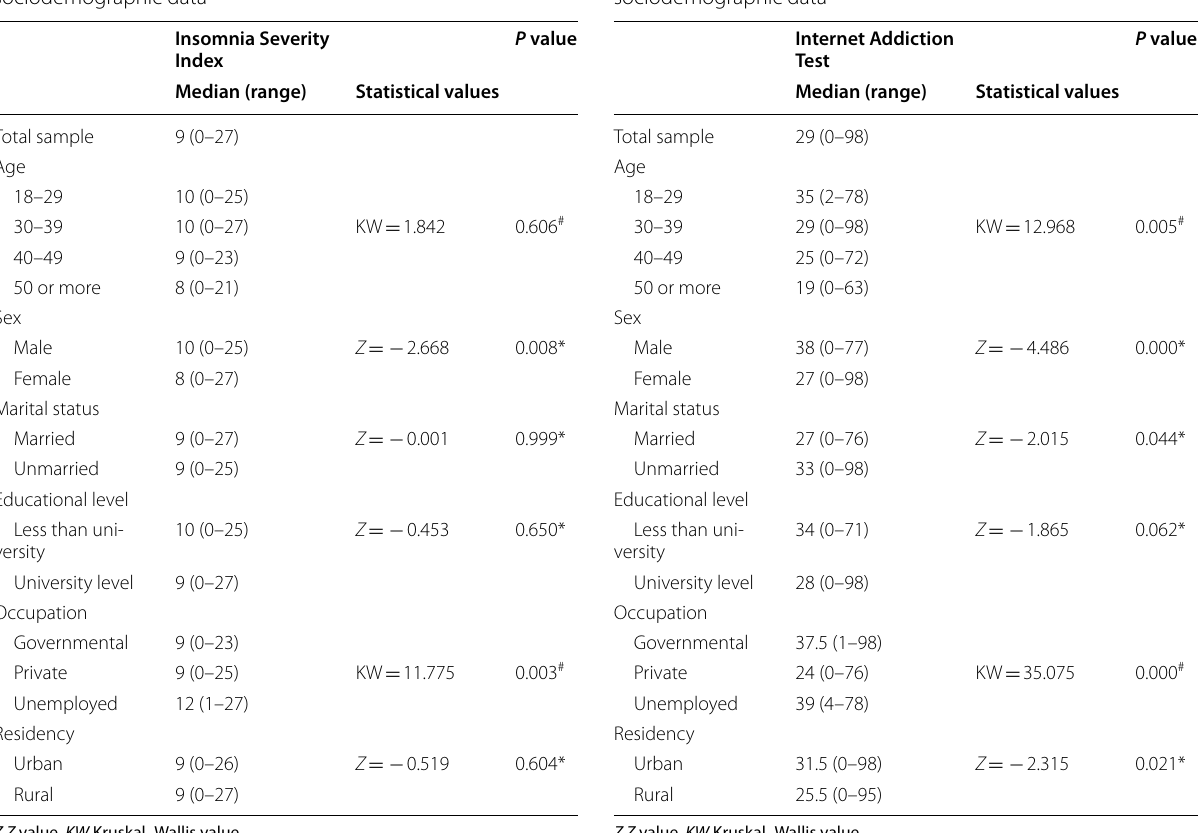
Table 4 Relation between Internet Addiction Test (IAT)